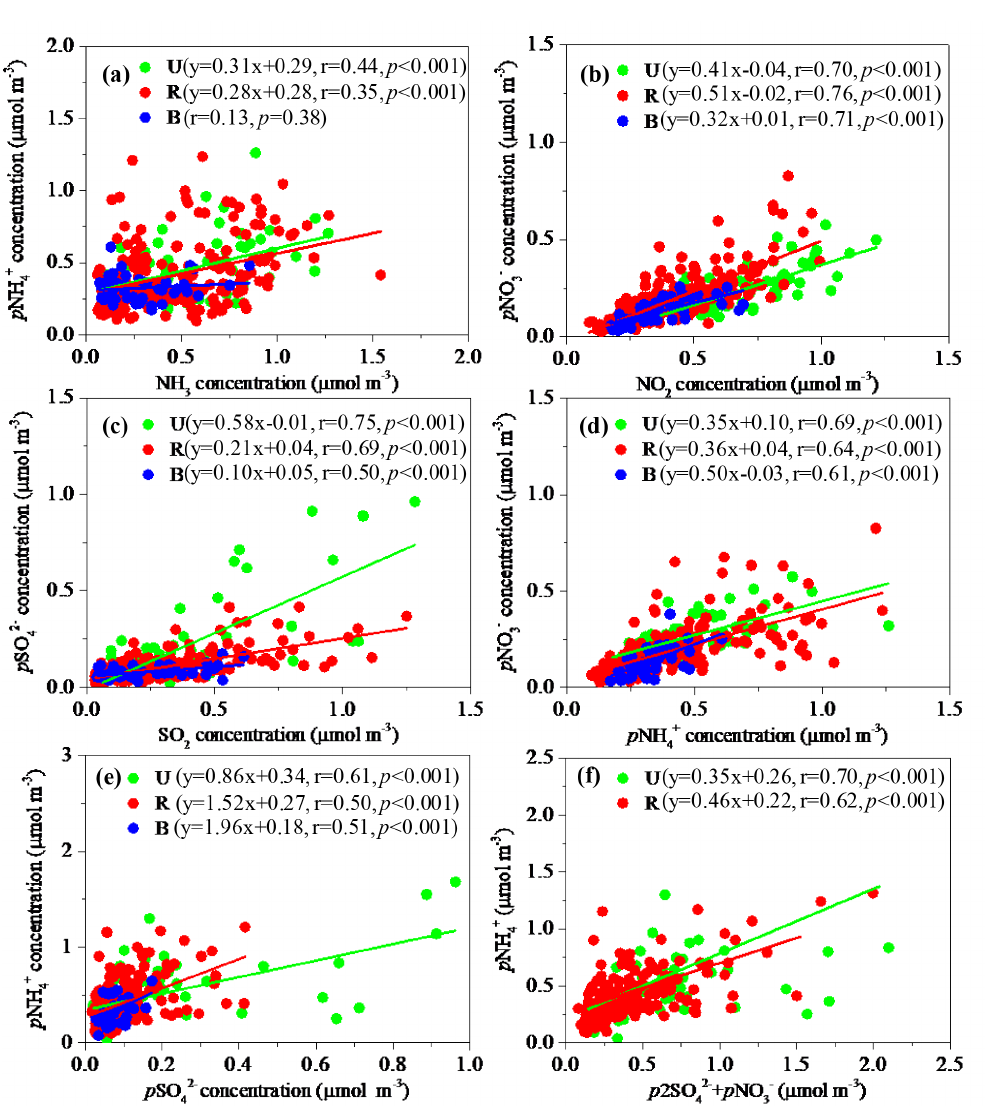
Figure 10. Correlations of monthly mean molar concentrations of (a) p NH + vs. NH 3 , (b) p NO − 4 + p NO − vs. p NH + , (e) p NH + vs. p SO 2 − , (f) p NH + vs. ( p 2SO 2 − ) at three land use types in eastern China. The number of sites with the 4 4 4 4 4 3 same land use type in each region can be found in Table